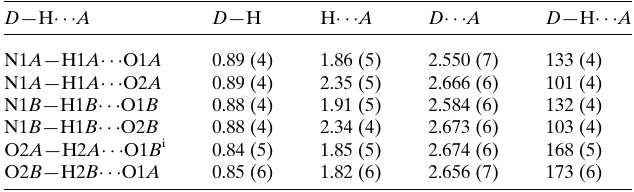
Table 1 Hydrogen-bond geometry (A˚ , (cid:2) ).